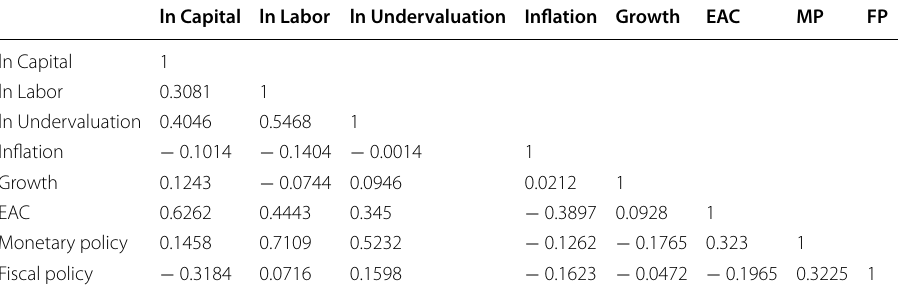
Table 12 Pairwise correlation of explanatory variables. Source: Author’s computations based on data from various sources